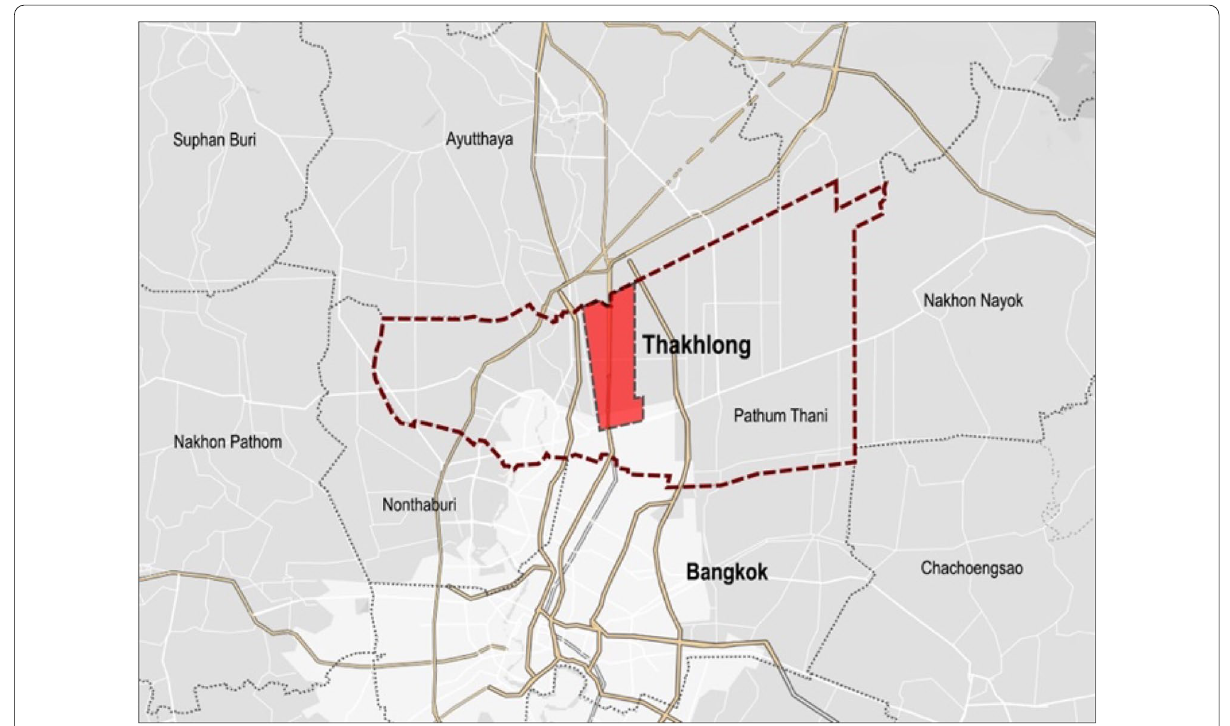
Fig. 1 Macro Scale of the site study connecting to Bangkok and Pathum Thani. (Adapted from Google Map